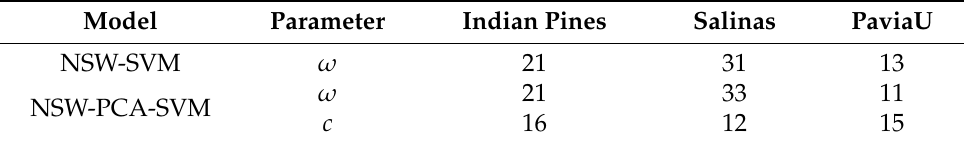
Figure 4. The OAs of NSW-PCA-SVM corresponding to different values of c on the three datasets. According to the experimental results, the parameter settings of NSW-SVM and NSW- PCA-SVM on the three datasets are obtained, as shown in Table 4. Table 4. Parameter settings of NSW-SVM and NSW-PCA-SVM on three